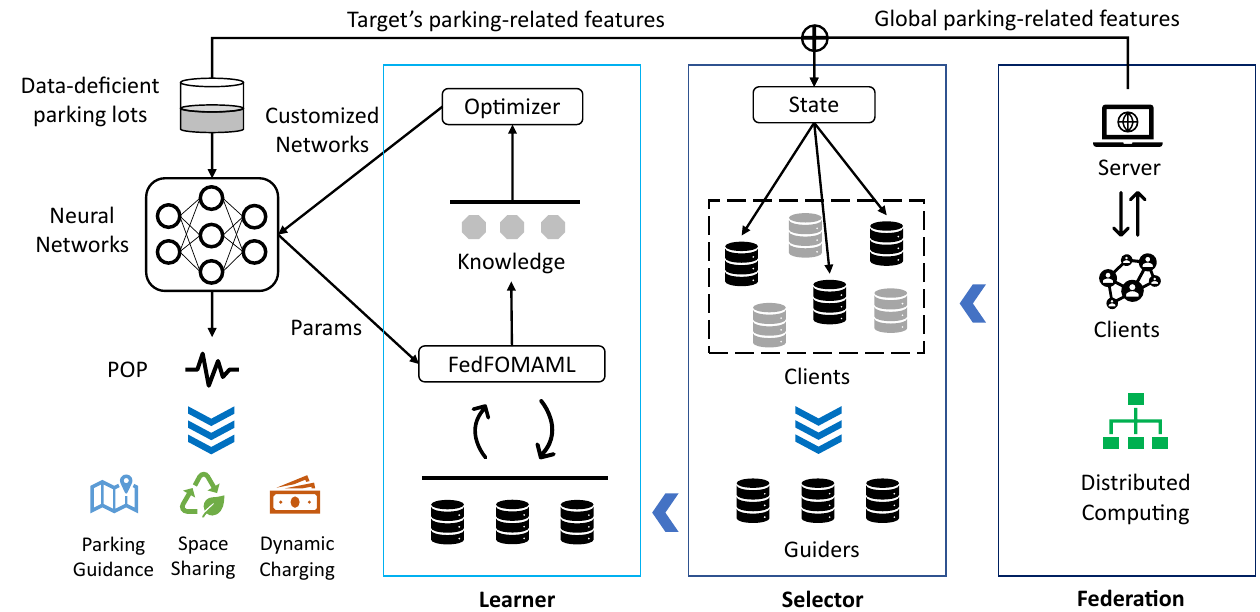
Figure 2. The architecture diagram of the proposed